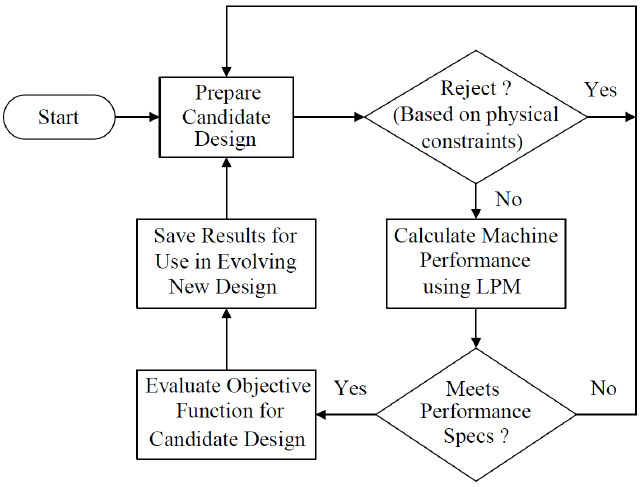
Figure 5. Flowchart describing the optimization process using LPM.